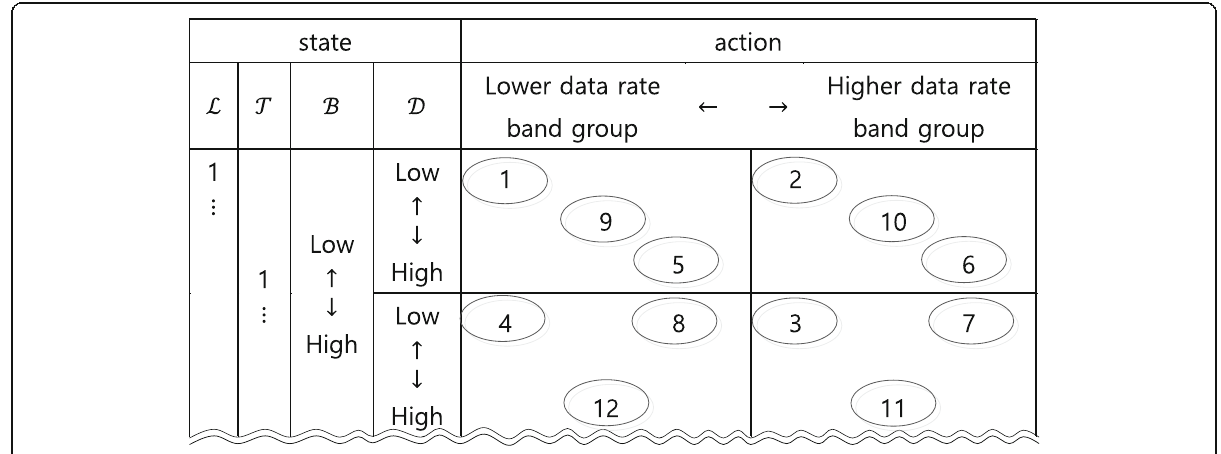
Fig. 9 Channel movement mechanism in Q-table and operating